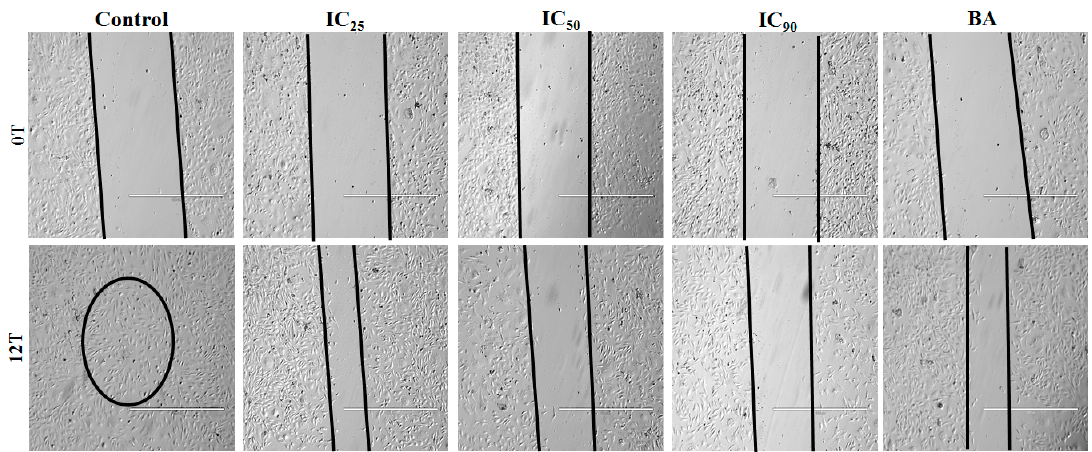
Figure 6. The anti-migratory effects of 50% ME of P. niruri against EA.hy926 cells. Photos were taken at 4× magnification (scale bar 1000 µm), BA: betulinic acid.